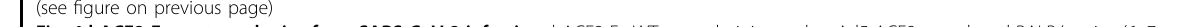
Fig. 4 hACE2-Fc protected mice from SARS-CoV-2 infection. hACE2-Fc WT was administrated to Ad5-ACE2-transduced BALB/c mice (6 – 7 weeks old, female, average weight 18.69 ± 0.92 g) intraperitoneally at a dose of 50 mg/kg one day before (prophylactic) or after (therapeutic) SARS-CoV-2 infection (1 × 10 5 PFU, intranasally). Equivalent human IgG was administrated as a negative control. a, b Weight loss was monitored for 10 days ( n = 5 mice per group). c, d Lungs were harvested for viral titers at 1 dpi and 3 dpi for prophylactic group and 3 dpi for therapeutic group ( n = 3 mice per group). LOD limit of detection, gm gram. e Lung tissues were harvested at 4 dpi. Sections were stained with H&E ( n = 3 mice per group). Arrowhead indicates regions with focal in fi ltration of in fl ammatory cells. Representative pathological images were from three independent mice per group. Scale bars (black), 400 µm at 5× and 100 μ m at 20×, respectively. f Summary of histology score (necrotic cellular debris, mononuclear, edema and neutrophils) at 4 dpi. Score criteria was performed as described in Materials and Methods. Multiple comparisons following 1-way ANOVA and Kruskal – Wallis test were performed for statistical analysis. Bonferroni ’ s correction was used to avoid in fl ation of experiment-wise Type I error. g hACE2-Fc WT was administered at 1 dpi (50 mg/kg, 30 mg/kg, 20 mg/kg, 10 mg/kg, 5 mg/kg, 1 mg/kg). Lungs were harvested for viral titers at 3 dpi ( n = 3 mice per group). LOD limit of detection. Multiple comparisons following one-way ANOVA and Kruskal – Wallis test were performed for statistical analysis. Bonferroni ’ s correction was used to avoid in fl ation of experiment-wise Type I error. h Pearson ’ s correlation coef fi cient was used to assess the correlation between lung viral titer and hACE2-Fc administration dose. * P ≤ 0.05, ** P ≤ 0.01, *** P ≤ 0.001, **** P ≤